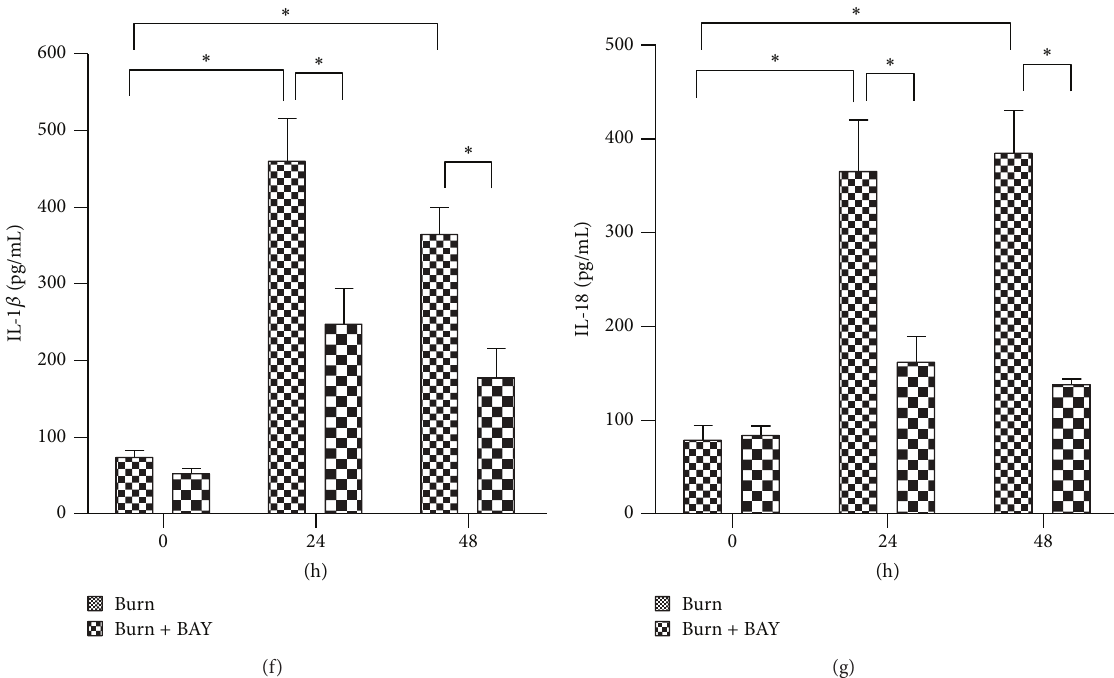
Figure 5: BAY11-7082 inhibited the NLRP3 inflammasome signals of AMs challenged with burn serum. AMs cells were exposed to 10% sham serum (0h in burn group), 10% sham serum + BAY11-7082 (0h in burn + BAY group), 10% burn serum, and 10% burn serum + BAY11-7082 for 24 h or 48h. BAY11-7082 was treated immediately after serum challenge. Real-time PCR showed the mRNA expression ((a) and (b)) of NLRP3 and Caspase-1 in macrophages exposed to burn serum for 24 h or 48 h. Immunoblots showed the protein level change ((c), (d), and (e)) of NLRP3 and Caspase-1 in each group. The release of IL-1 𝛽 (f) and IL-18 (g) in the supernatant was tested by ELISA. Results represent mean ± SEM of six independent experiments. ∗ 𝑃 < 0.05 . AM, alveolar